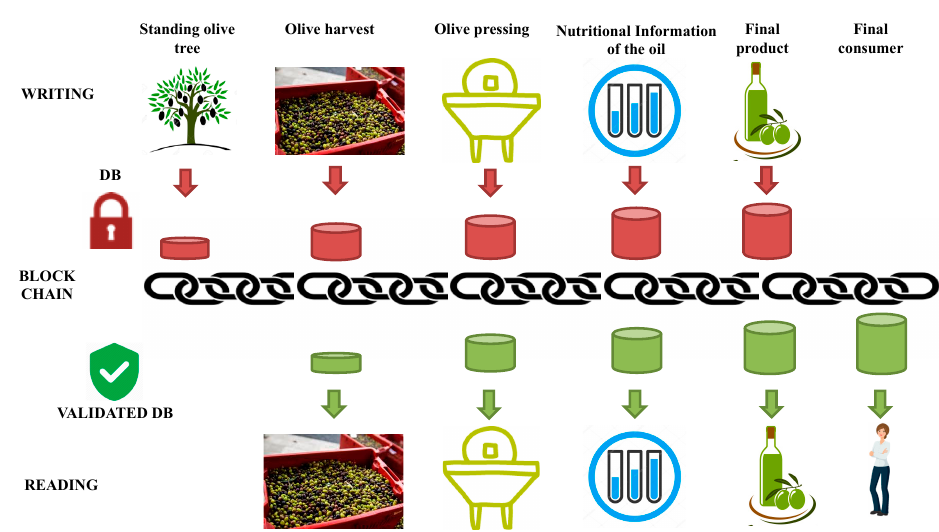
Figure 4. A schematic description EVOO traceability with implemented the blockchain data flow.